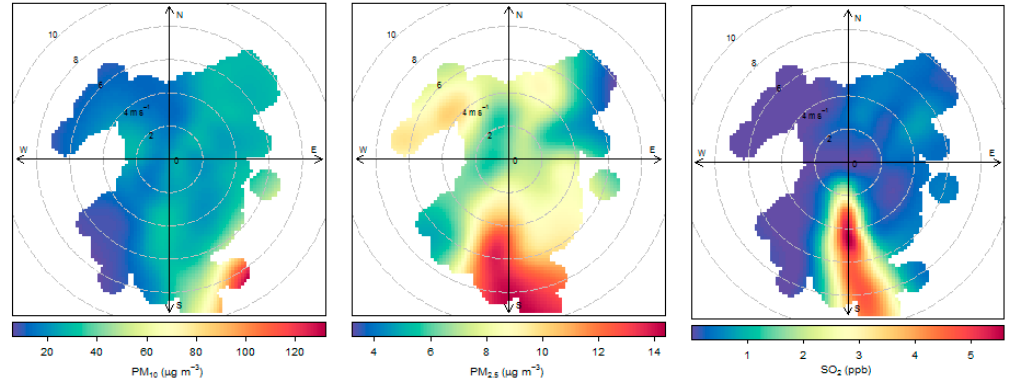
Figure 4. PM 10 , PM 2.5 and SO 2 polar bivariate plots of hourly average measurements from the OEH air quality station at Wollongong during the MUMBA